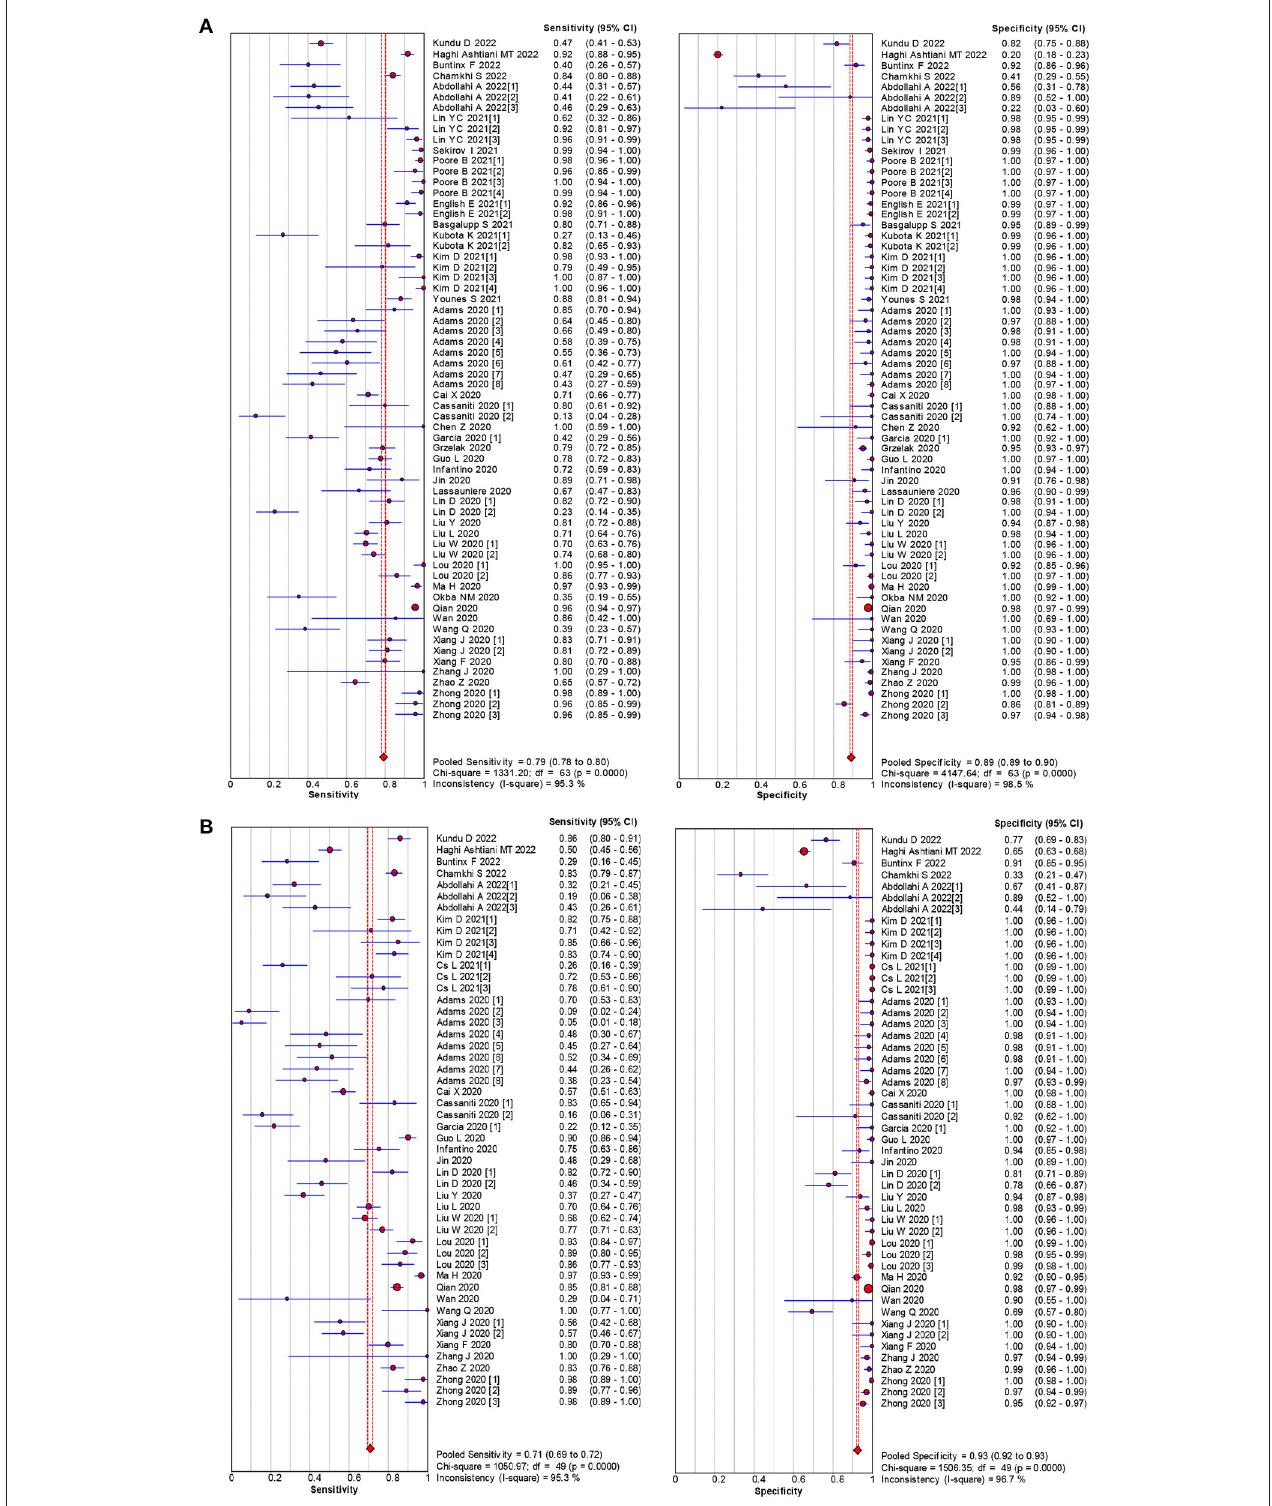
FIGURE 2 | Forest plot of sensitivities and specificities IgG (A) and IgM (B) for predicting COVID-19 diagnosis.